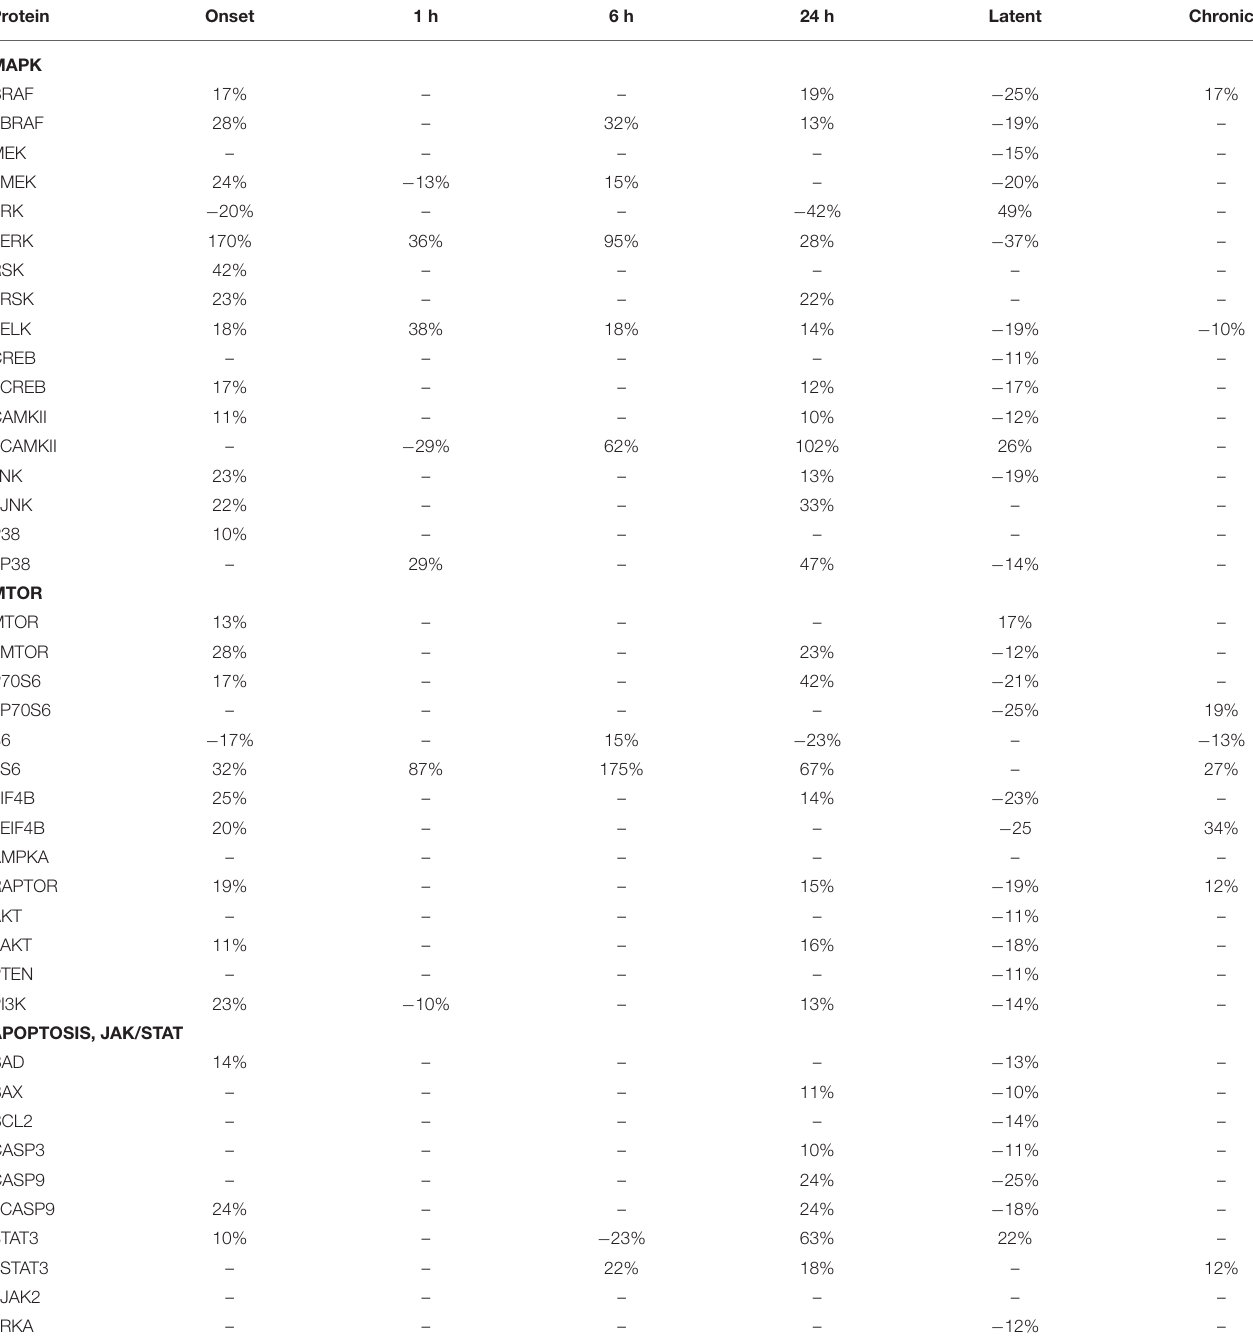
TABLE 3 | Protein changes in cortex, MAPK, MTOR, JAK/STAT, and apoptosis pathway components (pilocarpine vs. saline at corresponding time points). Protein Onset